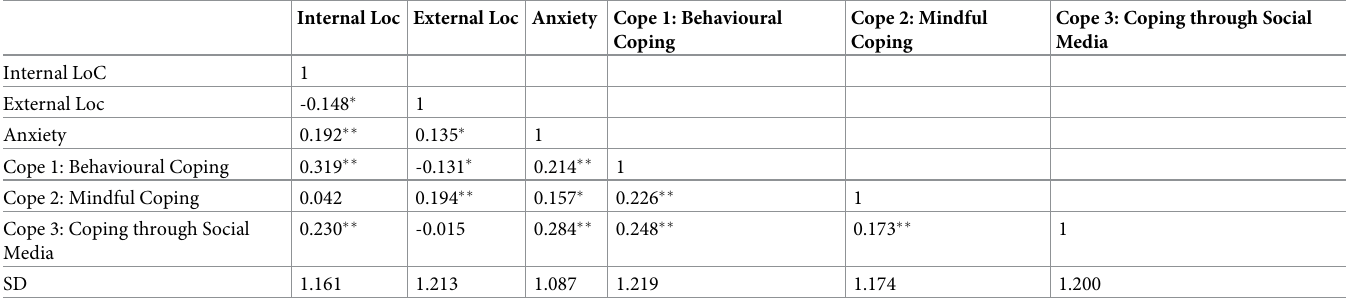
Table 5. Bivariate correlations between the latent